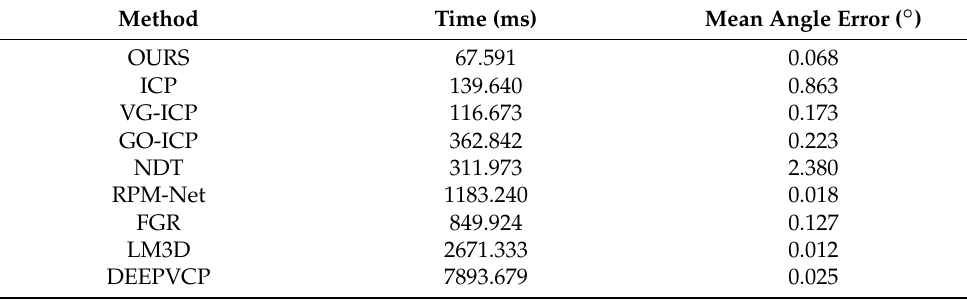
Table 5. Comparison of registration methods (average point cloud size: 3851). Method